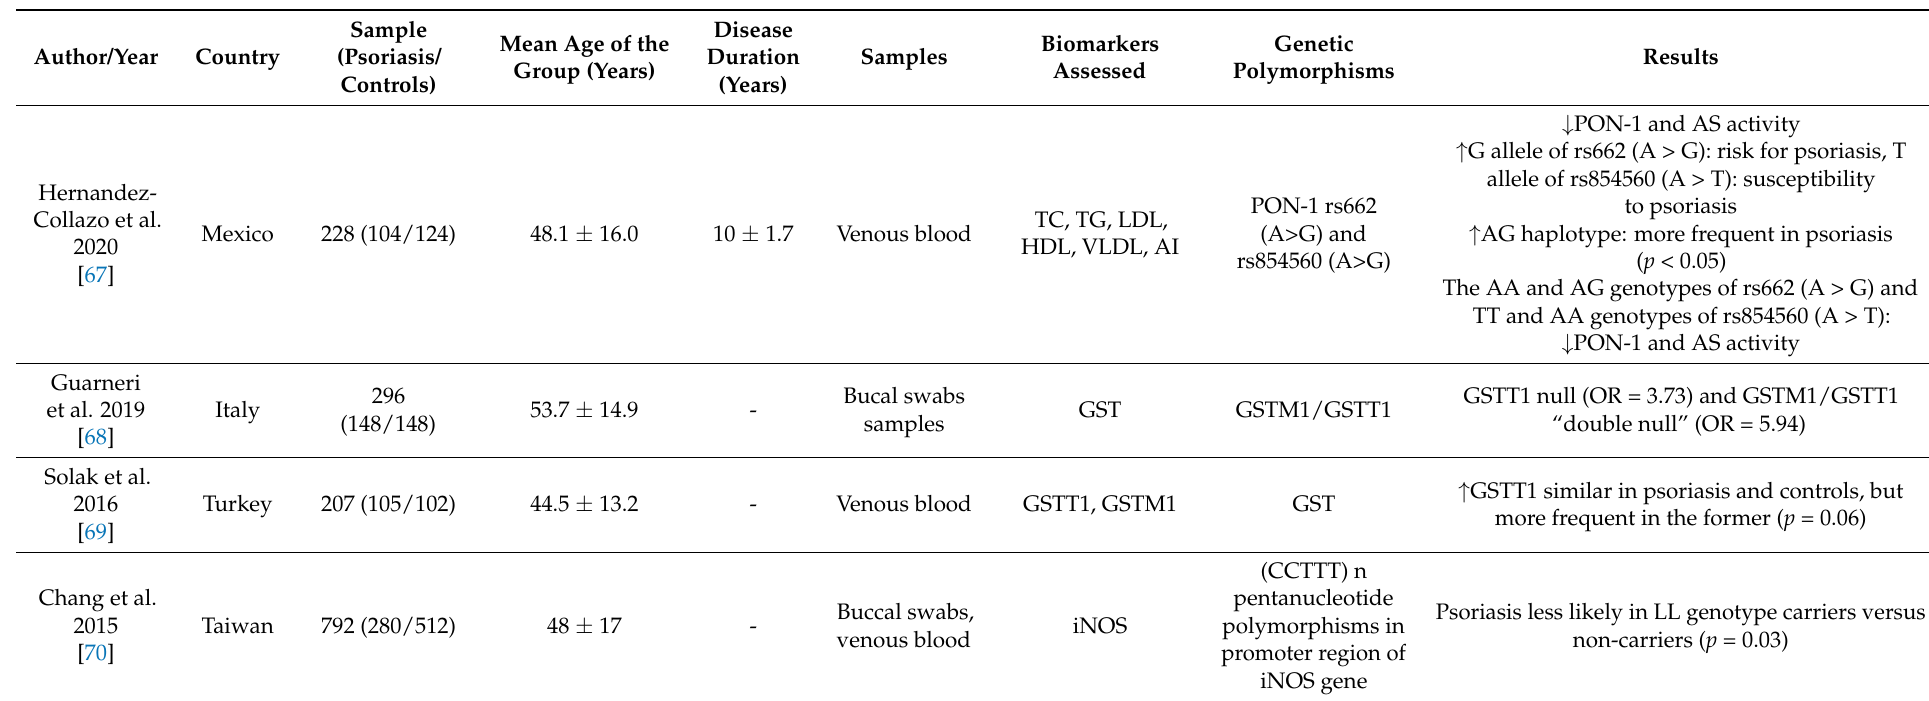
Table 2. Polymorphisms of Genes Encoding Markers or Enzymes of Oxidative Stress in